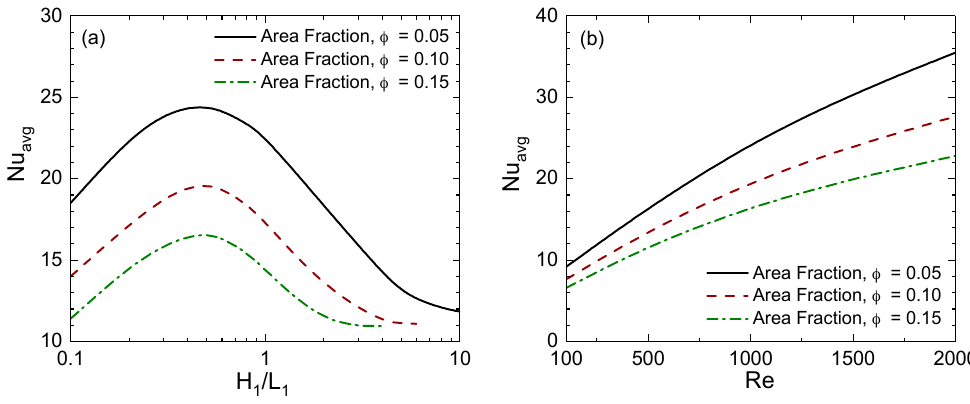
Figure 17. Effect of fin area fraction on Nu avg as a function of ( a ) fin aspect ratio and ( b ) Reynolds number for the base case parameters (Re = 1000, Ra = 10 5 , ϕ = 1%, and φ = 0.05).